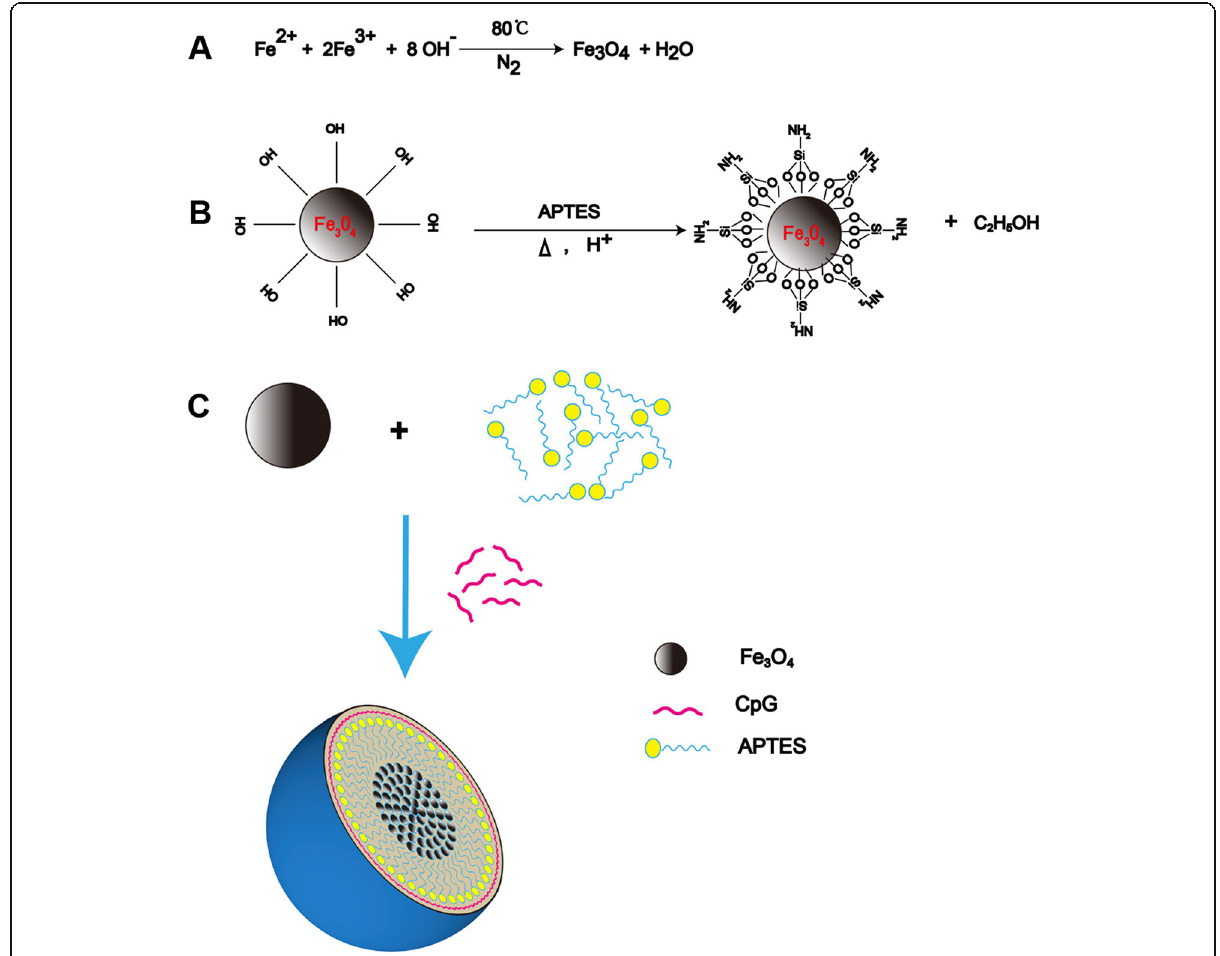
Fig. 1 Preparation of FeNP/CpG particles. a Equation of synthesis of Fe 3 O 4 magnetic particles using the co-precipitation method. b Hydrolysis and condensation reactions with production of silane polymer and silanization reaction of APTES on the magnetite surface to form FeNP particles. c Schematic diagram of the FeNP/CpG particles. CpG are bound to the surface of the FeNPs through electrostatic interactions to form FeNP/CpG